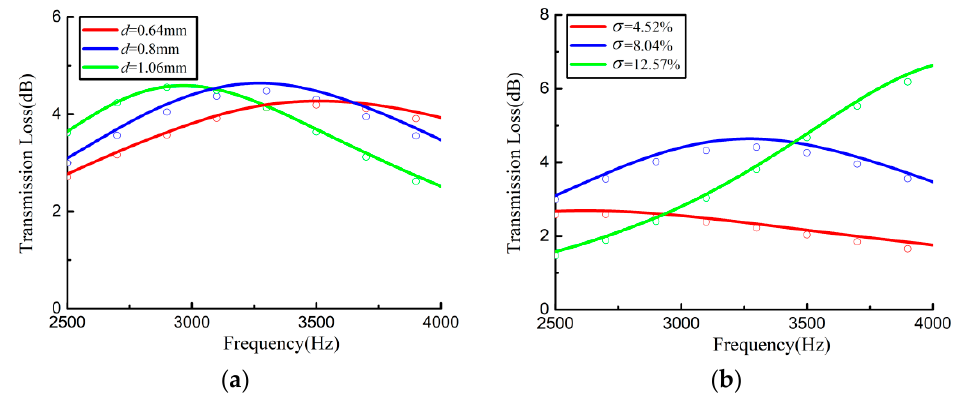
Figure 8. Transmission loss predicted using different perforated plate parameters. The solid lines